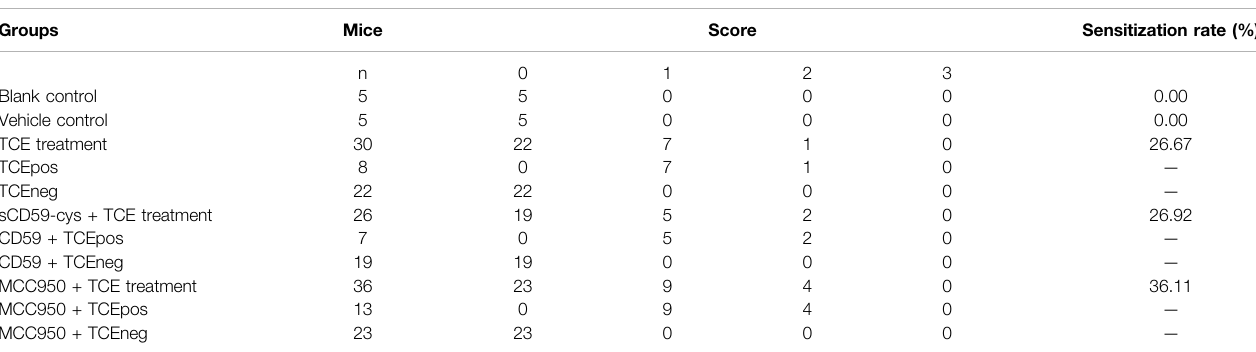
TABLE 2 | Groups and sensitization rate of mice in the present